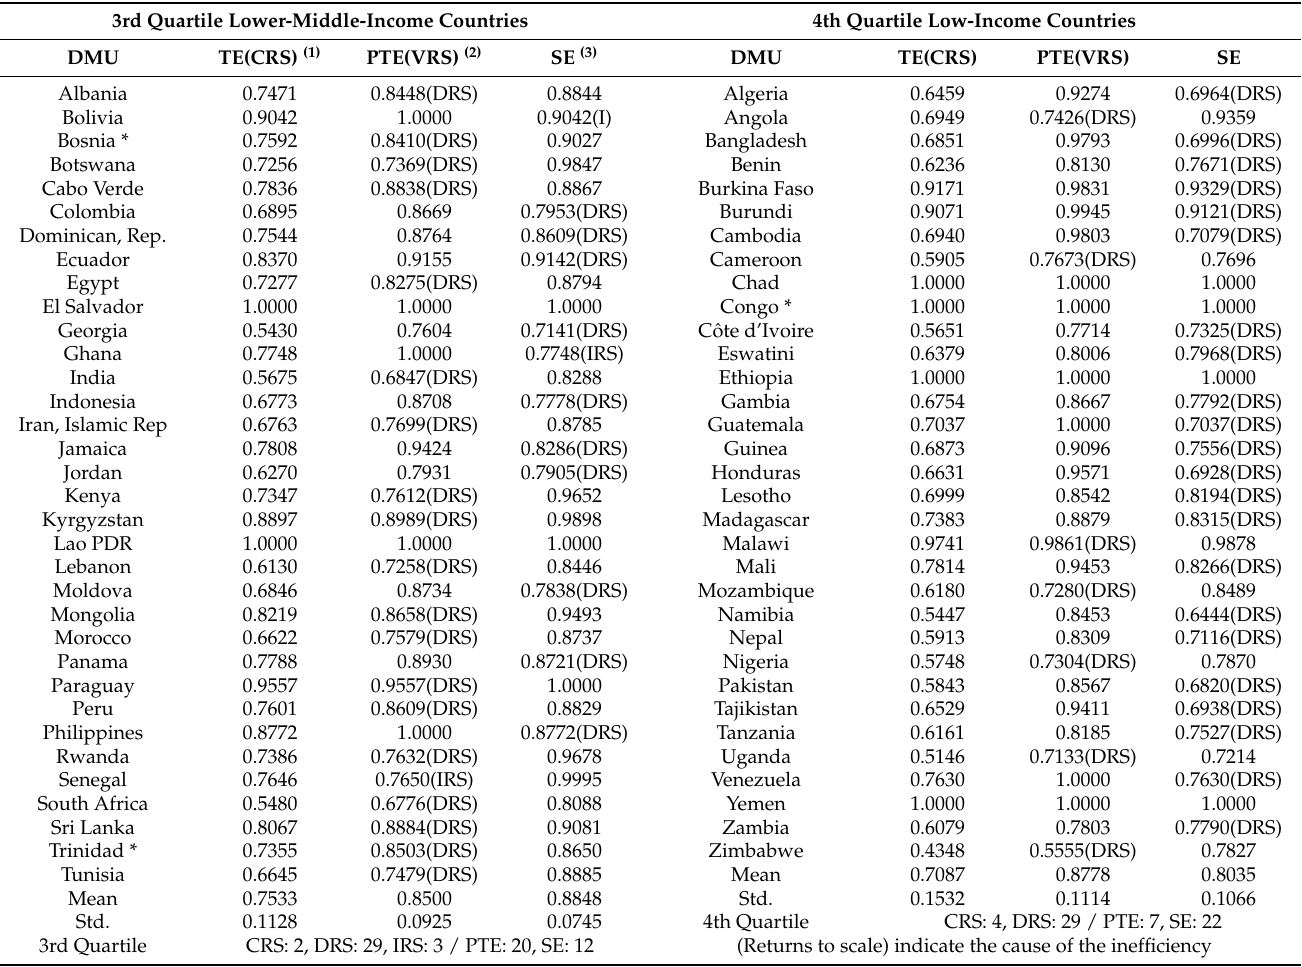
Table 5. Efficiency analysis results of 3rd quartile lower-middle-income countries and 4th quartile low-income